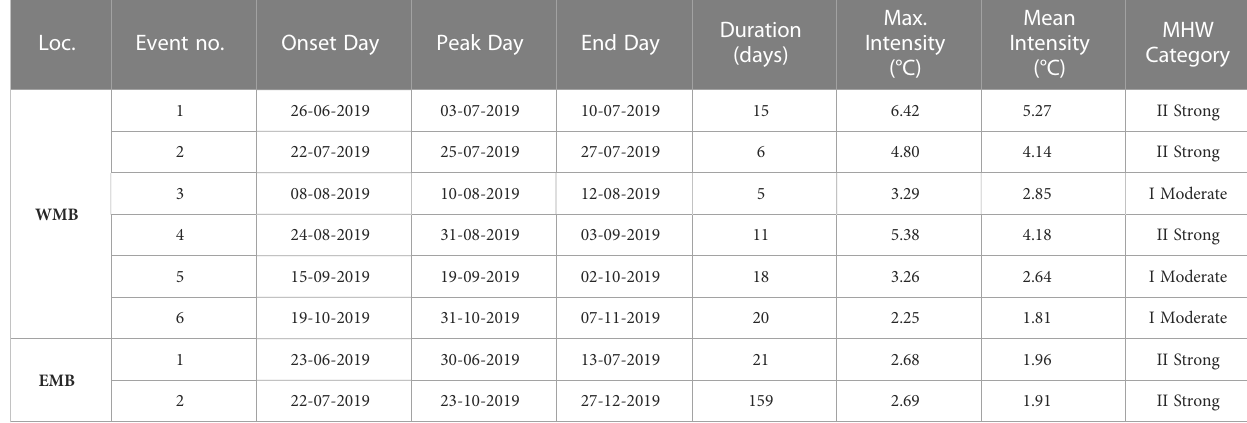
TABLE 1 MHW events characteristics in the WMB and EMB between June and December 2019.